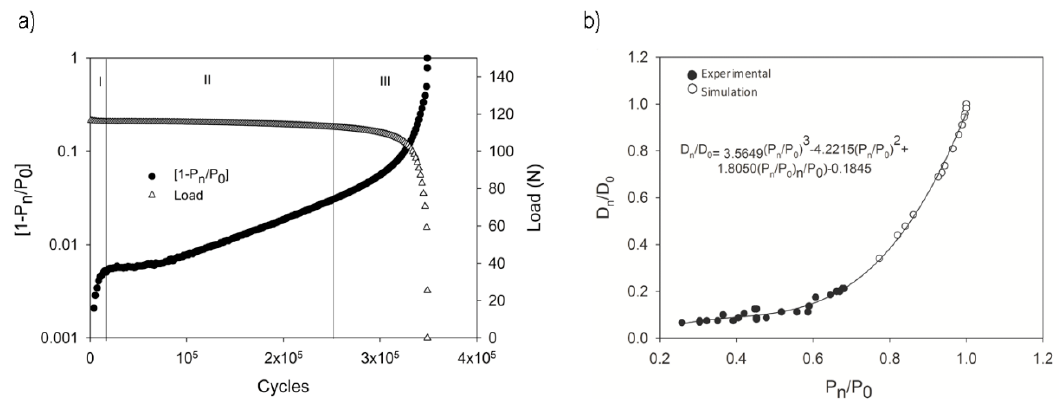
Figure 5. Load and percentage of load change during testing for a deflection of 1.057 mm ( a ) and the correlation between the load ratio and diameter ratio (cracking) ( b ).